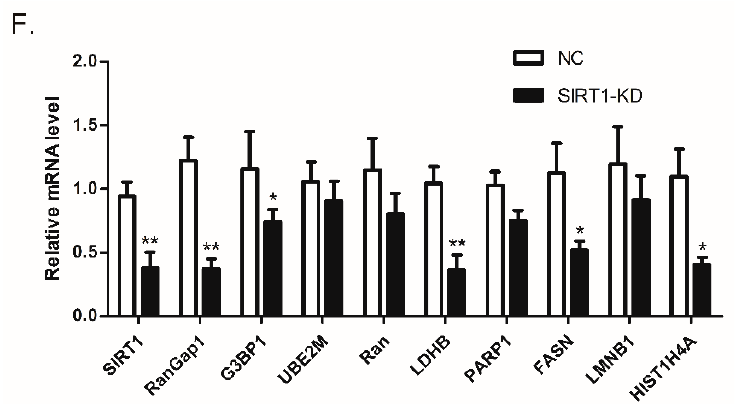
Figure 4. SIRT1 regulates RanGap1 expression. After treating with 20 µ M resveratrol for 24 h, or having SIRT1 over-expressed or knocked down in HEK 293T cells, the relative mRNA levels were determined by RT-PCR and the protein levels were detected by Western blot. ( A ) SUMO1-RanGap1 was increased after activation of SIRT1. ( B ) SUMO1-RanGap1 was increased in SIRT1-OE cells. ( C ) RanGap1 was decreased in SIRT1-KD cells. ( D – F ) The mRNA levels of SIRT1, RanGap1, G3BP1, FASN, UBE2M, Ran, LDHB, TCP1, LMNB1, HIST1H4A and PARP1 from cells as above. The GAPDH was used as a loading control. The pooled data were shown here as the mean ± SEM, and the significant differences from control cells were shown in p < 0.05 (*), p < 0.01 (**), and p < 0.001 (***). The independent experiments were repeated at least three times.